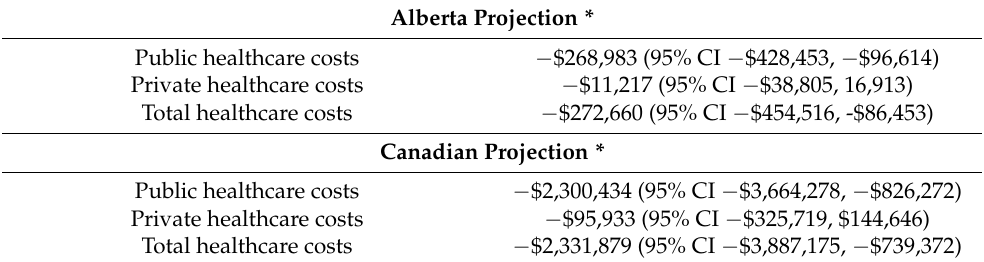
Table 6. Provincial and national cost difference projections (no body checking–body